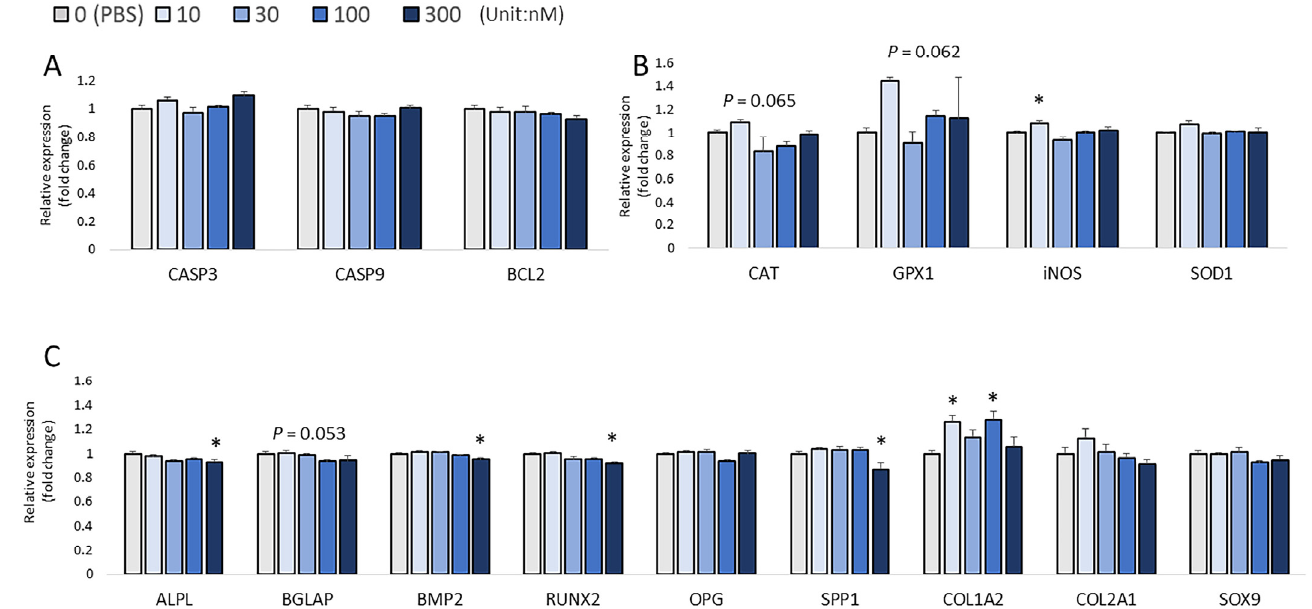
Figure 7. Effects of H 2 O 2 on the mRNA expression of three sets of genes in chicken embryos at 72 h post-injection. ( A ) Apoptotic genes’ expression ( B ) Antioxidant enzymes’ gene expression ( C ) Expression of bone formation markers. Each value represents the mean ± SEM (N = 8). Treatments with * showed a significant difference compared with the control using the Dunnett’s test, p < 0.05. At 72 h post-injection, the lethality rates were up to nearly 35%, but the mortality rate did not depend on the treatment doses. In addition, there were no significant changes in the expression of apoptosis-related marker genes among the treatments ( CASP3 , CASP9 , ( p = 0.065; Figure 7B) and GPX1 ( p = 0.062; Figure 7B) with H 2 O 2 treatment. The